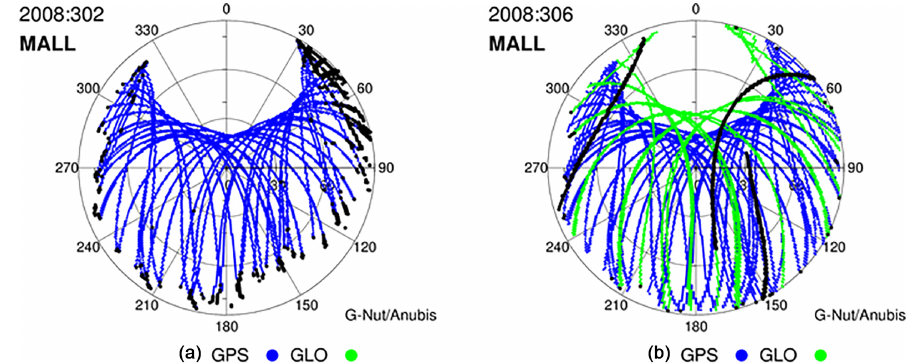
Figure 6. Sky plots before (a) and after (b) replacing the malfunctioning antenna at the MALL site (30 October 2008). Blue and green dots represent GPS and GLONASS (GLO), respectively, while black dots indicate single-frequency